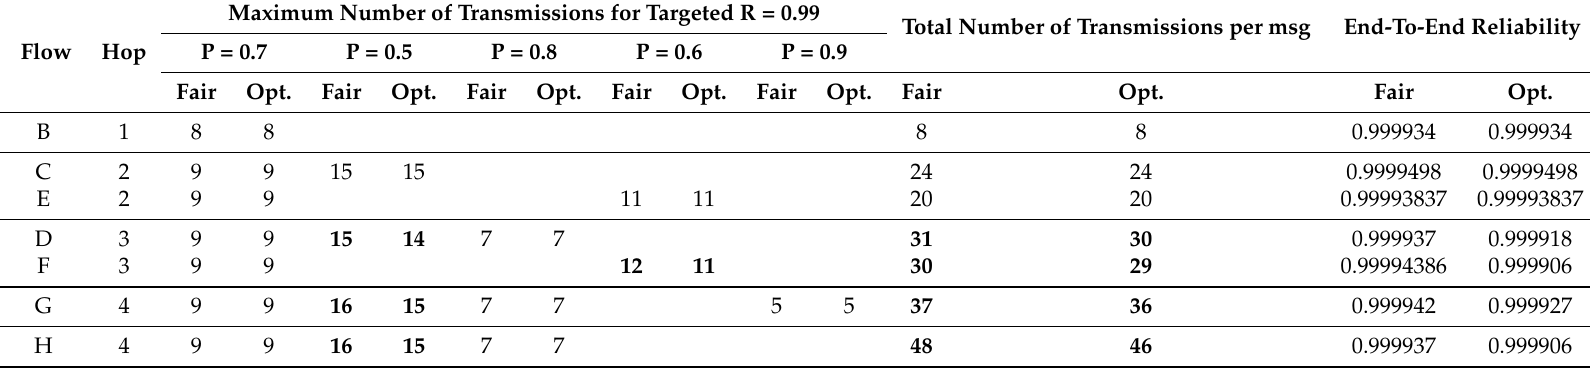
Table 6. Comparison of MFair and MOpt for a targeted end-to-end reliability R = 0.9999 on seven flows. Maximum Number of Transmissions for Targeted R =